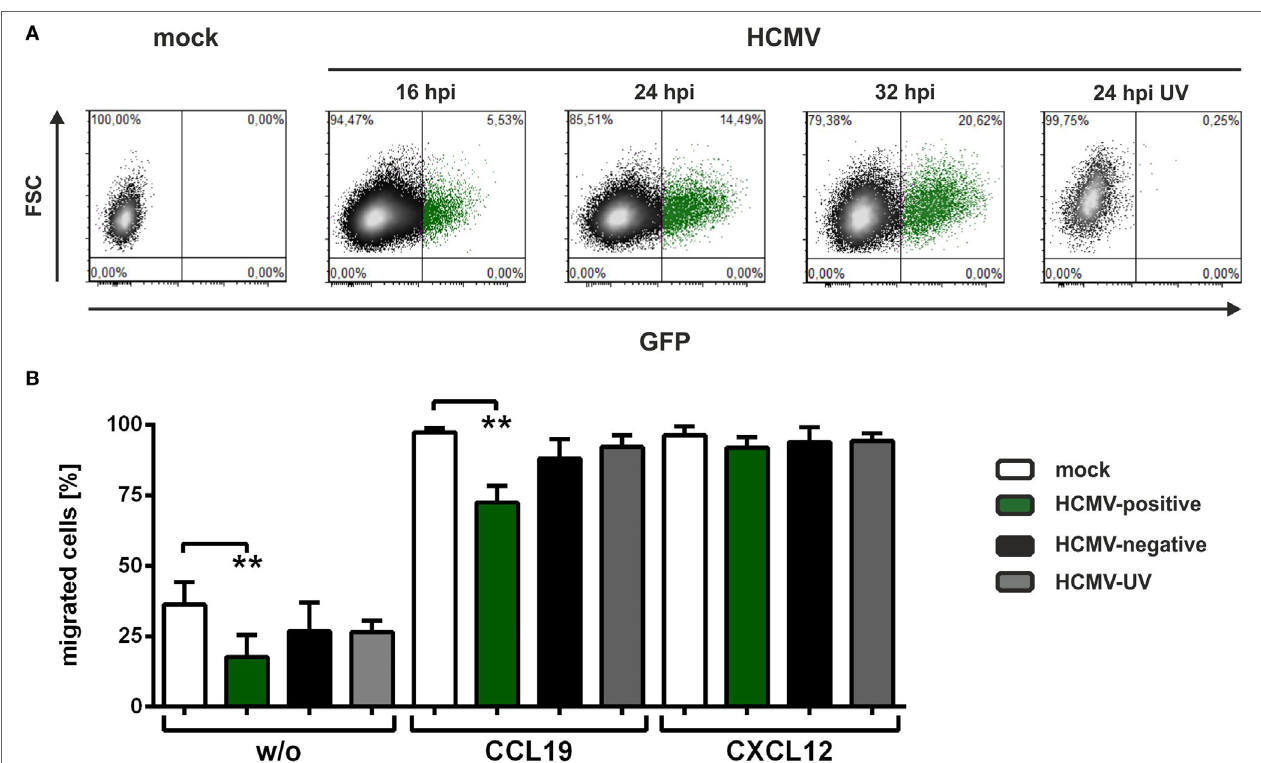
FigUre 1 | human cytomegalovirus (hcMV)-infected mature Dcs (mDcs) show decreased transwell migration toward ccl19 . (a) Mature dendritic cells were mock-, HCMV- or HCMV-ultraviolet (UV)-infected and analyzed for infection rates at the indicated time points. Mock or HCMV/green fluorescence protein (GFP)-negative mDCs are indicated as black dots, while HCMV/GFP-positive cells are marked in green. (B) . Mock- (white columns), HCMV-infected mDCs (HCMV-positive cells are depicted in green and HCMV-negative cells in black columns), and HCMV-UV-infected mDCs (gray columns) were subjected to a transwell migration assay on fibronectin-coated transwell inserts 24 hpi. To induce chemotaxis the chemokines CCL19 or CXCL12 (100 ng/ml) were added to the lower wells. As control no chemokine was added for spontaneous migration, indicated as “w/o.” Migration was evaluated after 2 h, and the percentage of migrated mDCs was calculated in the lower well by determining cell number and infection rates of migrated cells in relation to the respective starting condition. The experiment was performed at least three times with cells from different healthy donors. Significant changes (** = p < 0.01) are indicated by